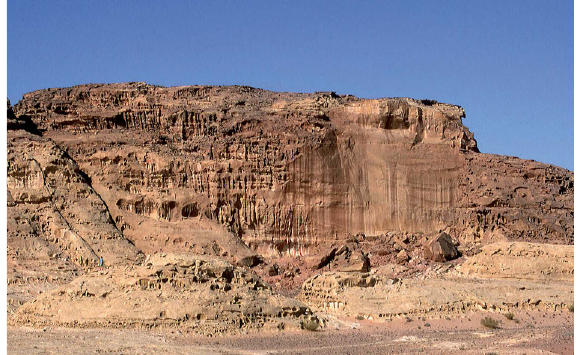
Fig. 5. Massive rock slope failure within the Umm ‘Ishrin Sandstone. Note the smooth surface of the exposed failure plane, with no cavernous weathering